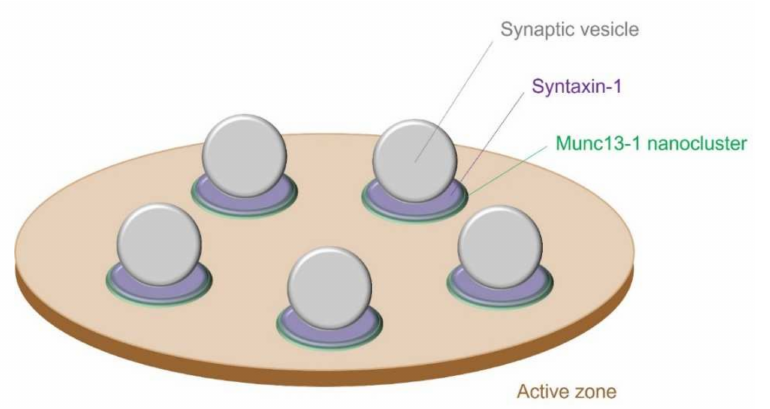
Figure 2. Model of Munc13-1 nanoclusters forming synaptic vesicle release sites. The Munc13-1 nanocluster (green) recruits syntaxin 1 (magenta) and forms a synaptic vesicle release site. The number of synaptic vesicle release sites corresponds almost exactly to the number of Munc13-1 nanoclusters, showing a one-to-one